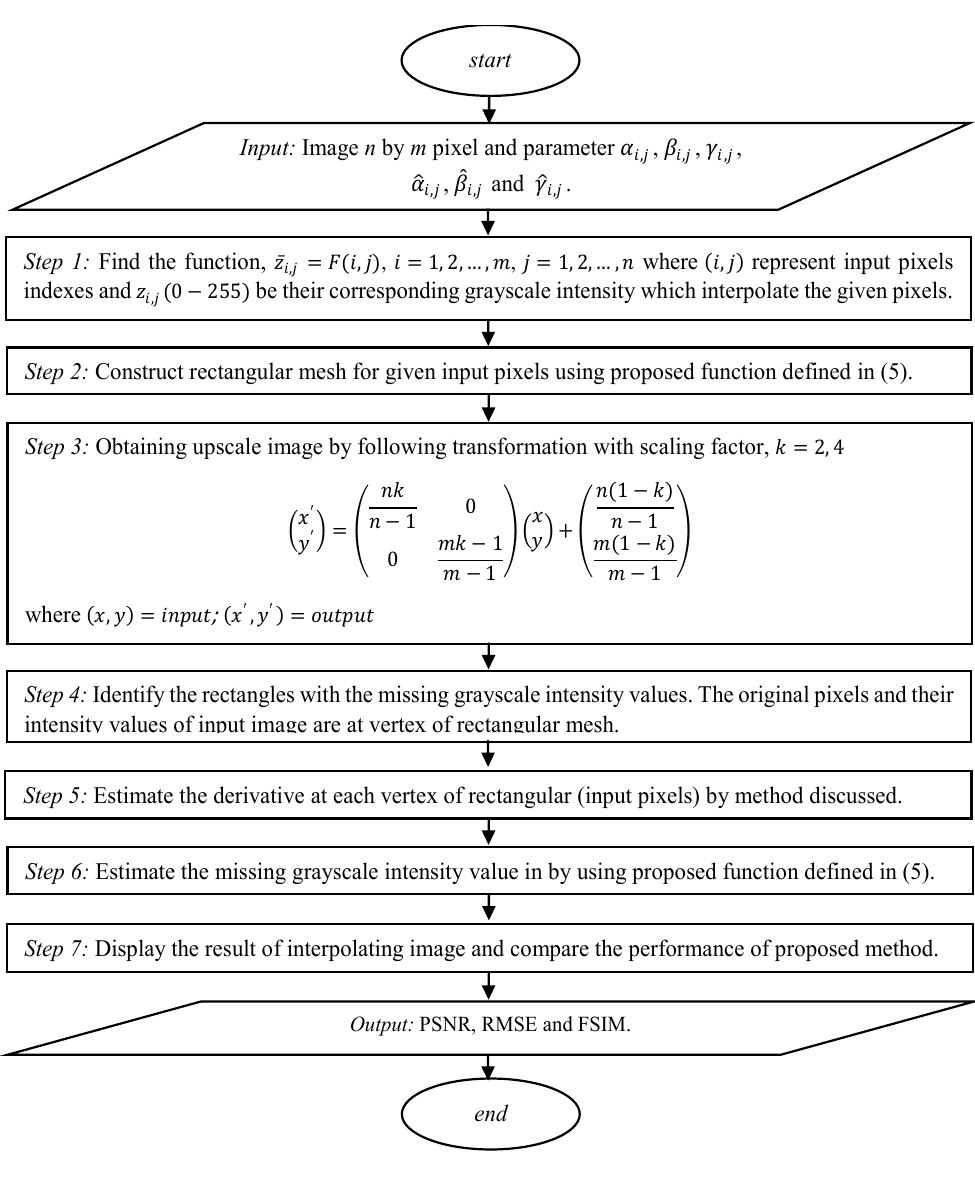
Figure 2. Flowchart steps of image scaling.